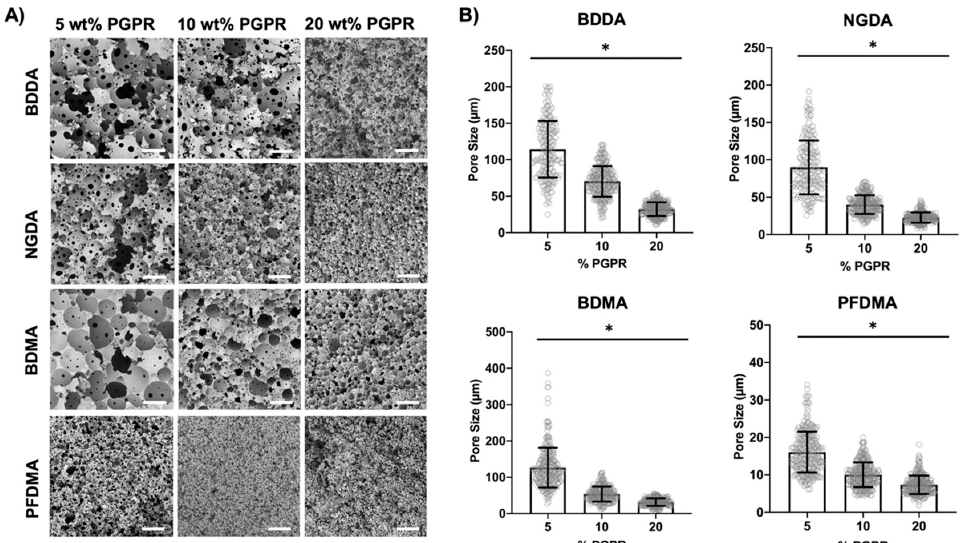
Figure 3. Representative scanning electron micrographs of fracture planes of BDDA, NGDA, BDMA, and PFDMA polyHIPEs fabricated with 5, 10, and 20 wt.% surfactant ( A ) and the effect of increasing surfactant concentration on polyHIPE pore size for all four macromers ( B ). Scale bar is 100 µm. * denotes statistical significance, p < 0.05.